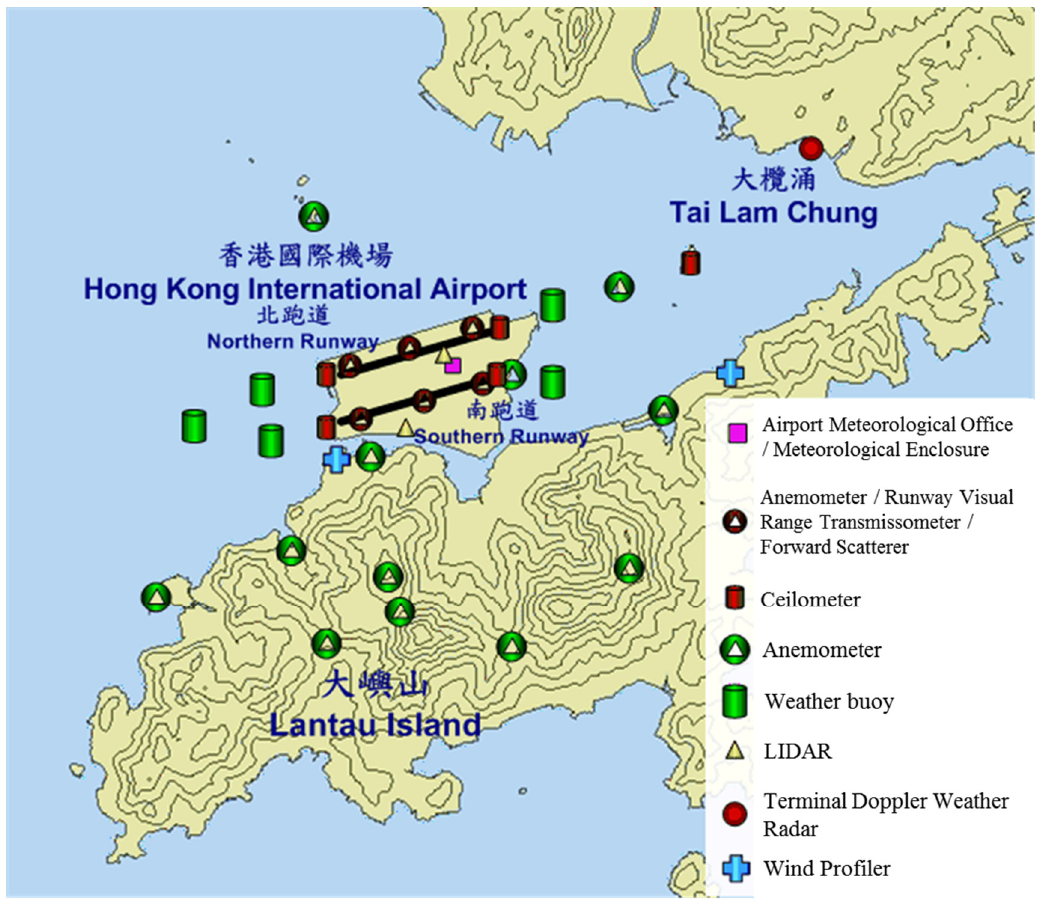
Figure 1. Schematic diagram of Hong Kong International Airport and location of Doppler